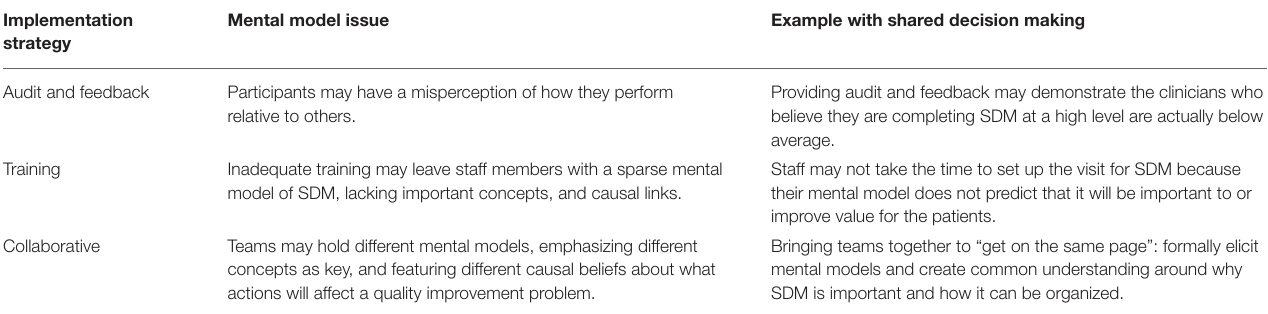
TABLE 2 | Example implementation strategies with mental model illustrations and examples with the concept of shared decision